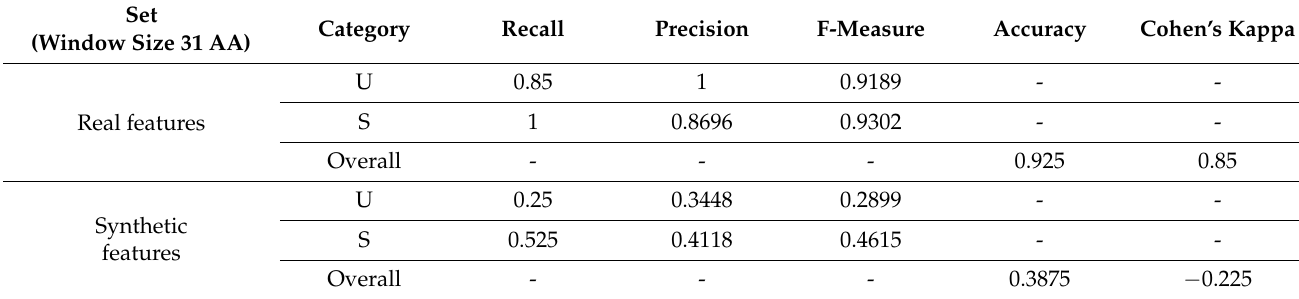
Table 2. Comparison of LR model on real versus synthetic features (see also Supplementary Figure S7).